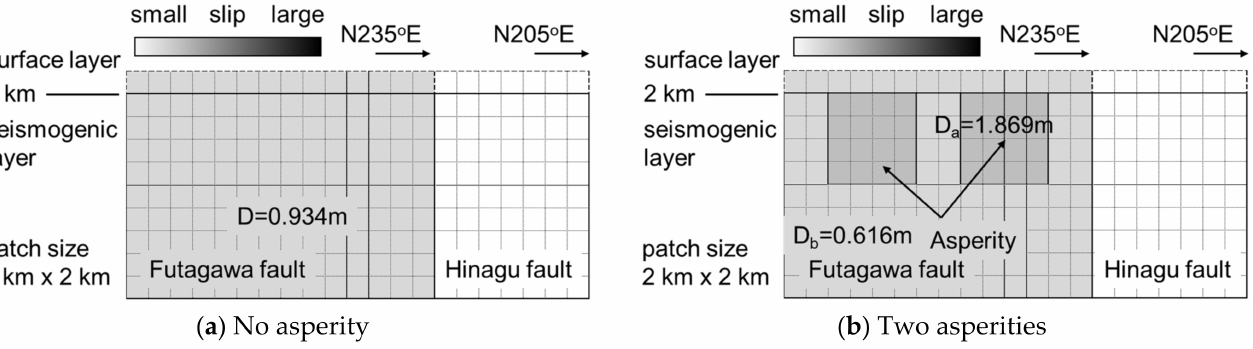
Figure 14. Setting the slip distribution based on the